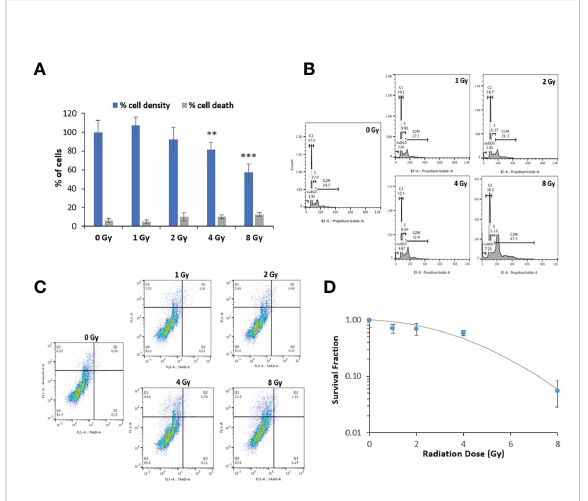
FIGURE 3 Proton radiation at 1-2 Gy does not cause signi fi cant toxicity but causes G2/M cell cycle arrest at higher doses. (A) Acute cytotoxic effect of proton exposure on NOK cells was assessed using the trypan blue exclusion test at 48-72 hr. The ratio of stained cells to the total number of cells was used to determine the percentage of cell death in each treated group (in gray), while the total cell density relative to the control group as 100% (in blue) was used to estimate the rate of cell proliferation. Asterisks on bars represent statistical signi fi cance in total cell density relative to control (** for p<0.01; *** for p<0.001). (B) Representative image of one of three experiments showing the cell cycle phases of NOK cells exposed to 0-8 Gy of protons at 48-72 hr. (C) Representative image of one of three experiments showing the Annexin V/7AAD pro fi le in NOK cells exposed to 0-8 Gy of protons at 48-72 hr. Annexin V-/7AAD − cell population is considered healthy, Annexin V-/7AAD+ is indicative of necrotic cells, whereas the Annexin V+/7AAD − and